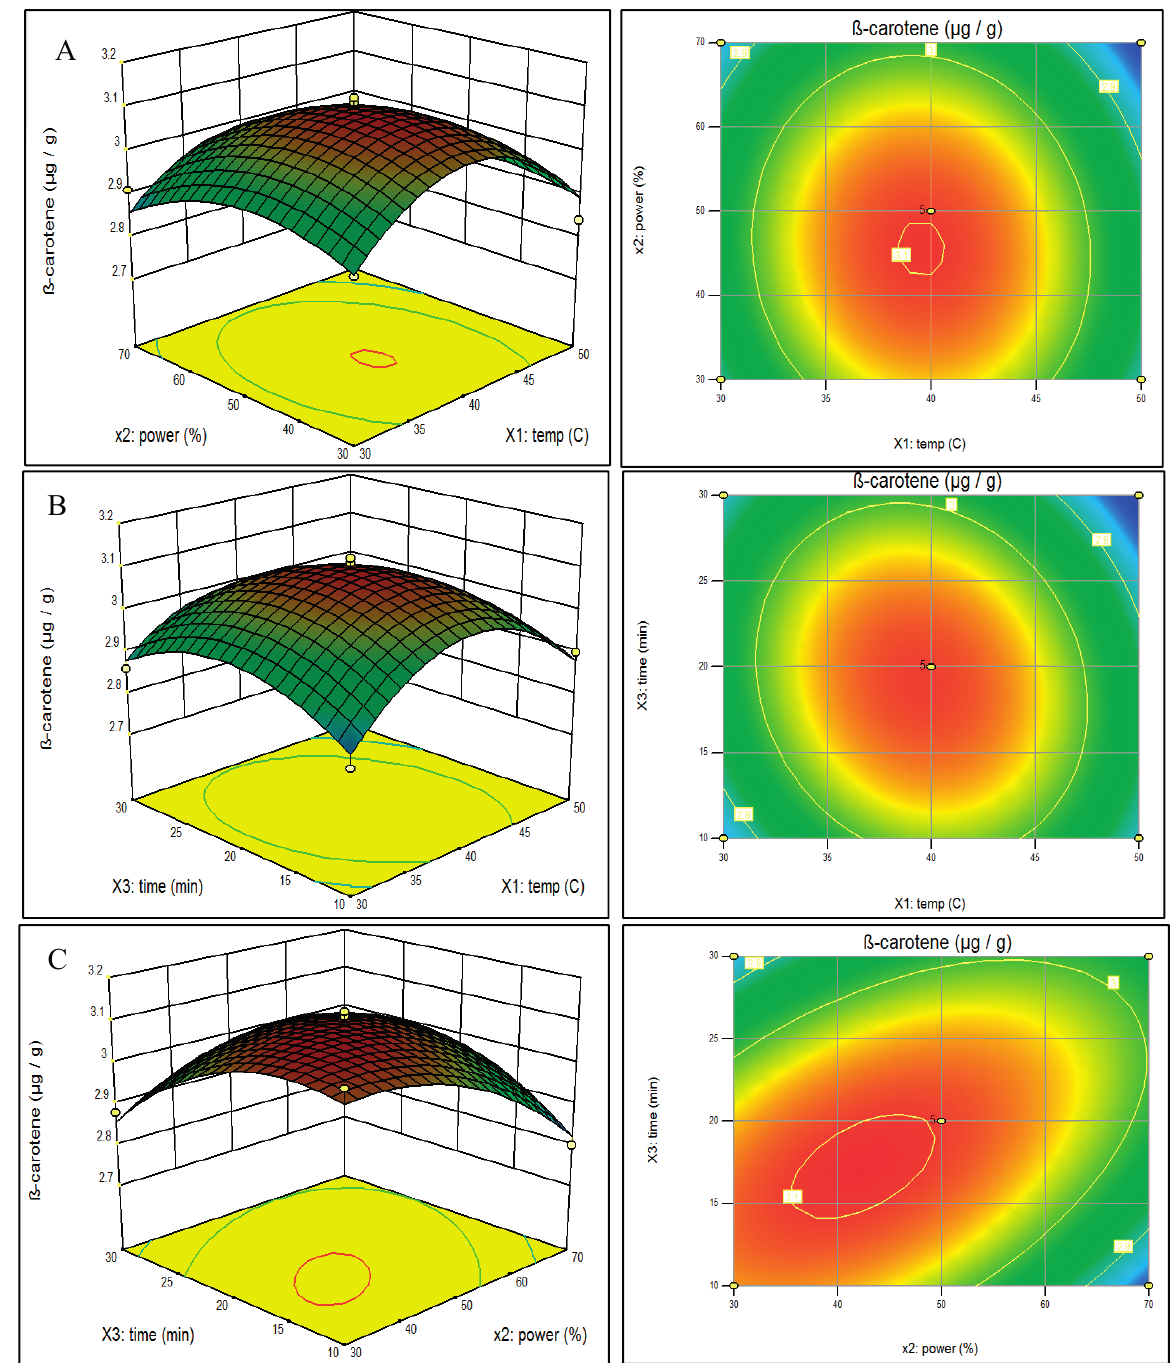
Figure 2. Response surface model plot showing the effects of independent variables on β -carotene content: panel A temperature and power; panel B temperature and time; and panel C power and